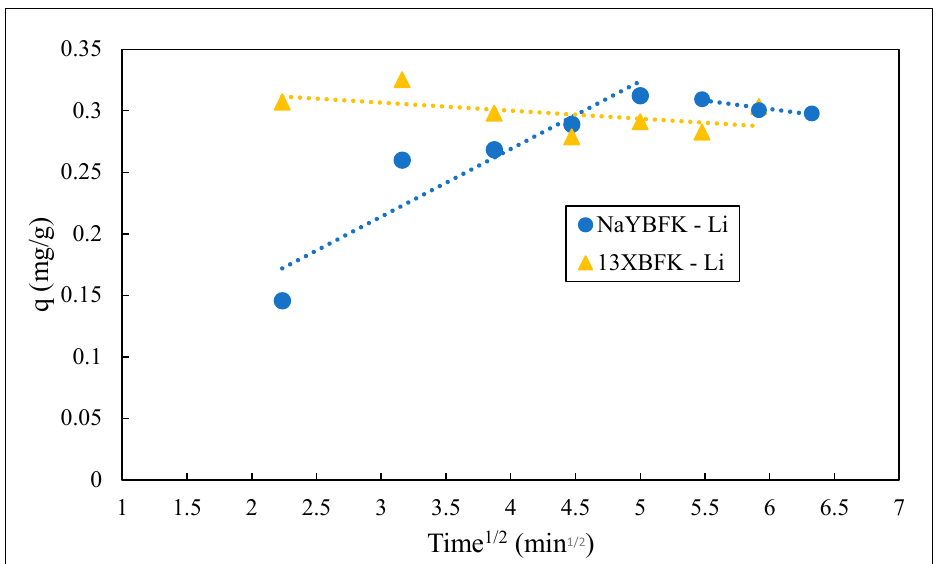
Figure 6. Webber-Morris plot for Co 2+ adsorption at 298 K. Conditions: 5 g/L of adsorbent dosage, 1100 rpm, and 40 mg/L of initial Co 2+ concentration.